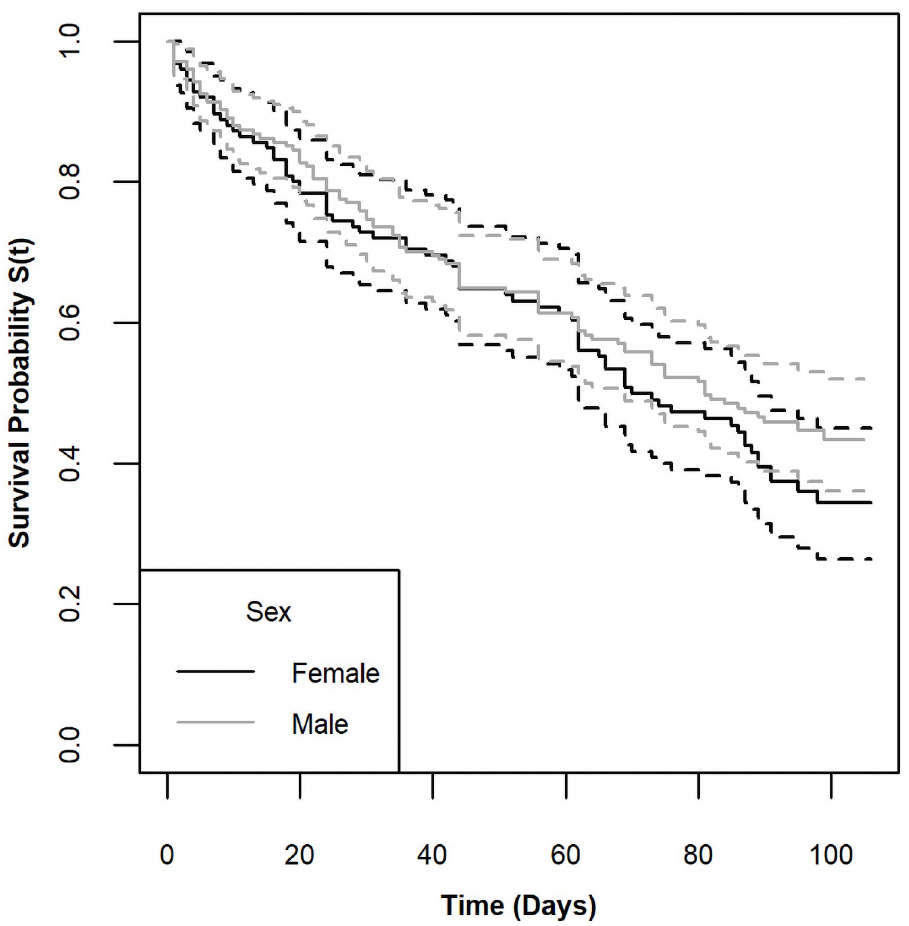
Fig 1. Kaplan-Meier survival curves by sex. Solid lines show the KM survival curves for females and males in black and grey, respectively. The dotted lines indicate confidence intervals.